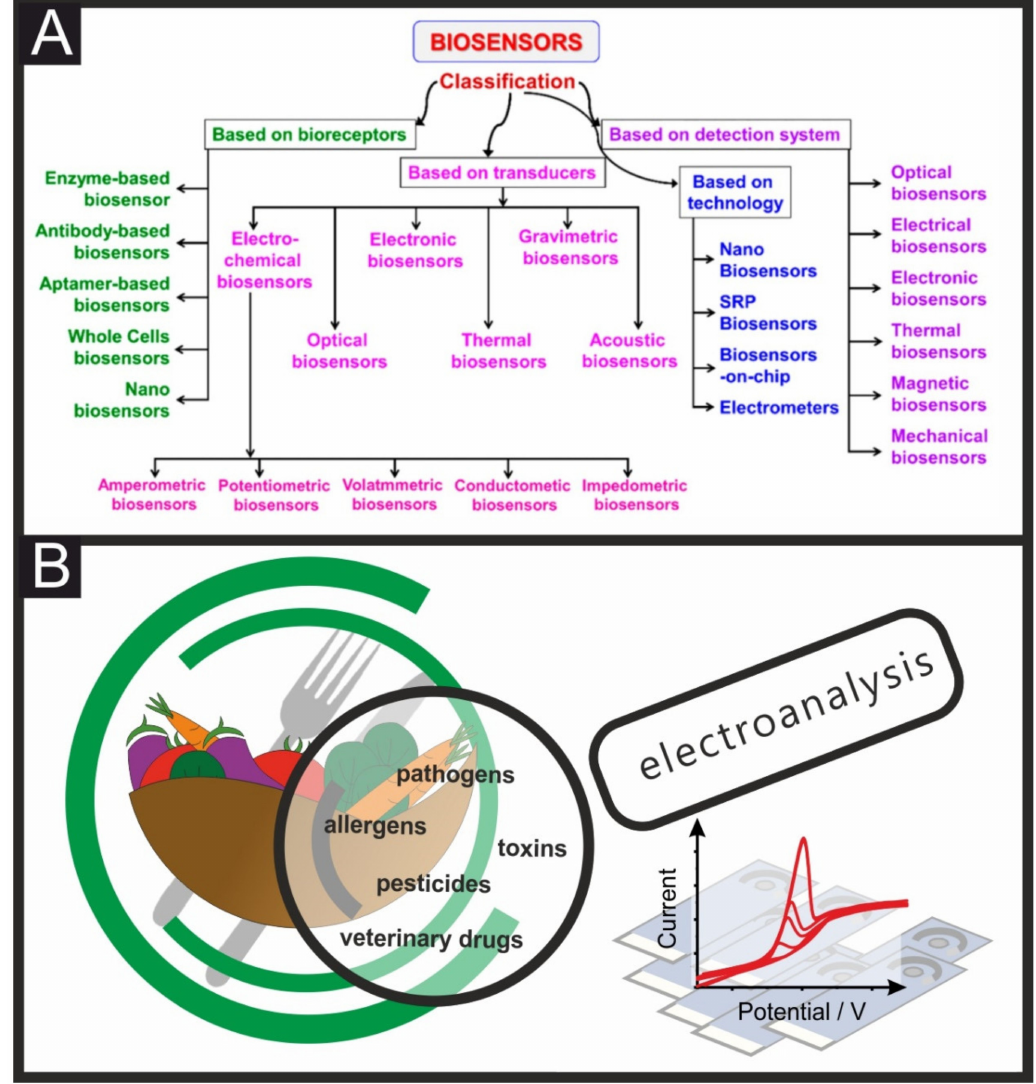
Figure 1. Classification of biosensors based on their bioreceptors, transducers, technology or detection system ( A ). Schematic representation of some of the multiple applications of tailored electrochemical sensing platforms towards food safety ( B